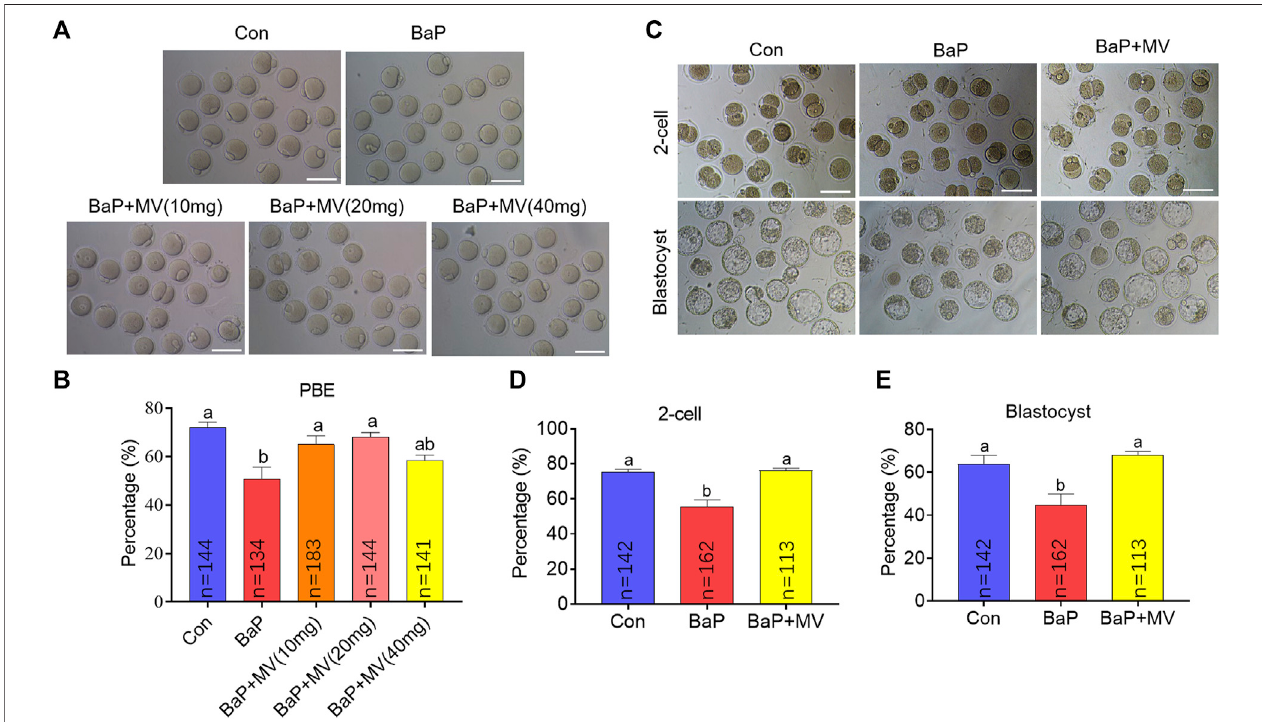
FIGURE 1 | Effects of MV on meiotic maturation and embryo development in BaP-exposed mice. Oocytes were matured in vitro to examine meiotic progression. (A) Representativeimagesofoocytesat13 hof invitro maturationindifferentgroups. (B) Theratesof fi rstpolarbodyextrusion(PBE)intheCon,BaP,BaP+MV(10 mg), BaP + MV (20 mg), and BaP + MV (40 mg) groups. BaP, Benzo(a)pyrene. MV, mogroside V. In vitro fertilization was performed to determine oocyte developmental competence. (C) Representative images of 2-cell embryos and blastocysts in the Con, BaP and BaP + MV groups. (D) Percentage of 2-cells in the Con, BaP and BaP+MVgroups. (E) Percentageofblastocysts intheCon,BaPandBaP+MVgroups. Scalebar (cid:2) 100 μ m.Thedataarepresented asthemean ± SEM. a-b Meansnot sharing a common superscript are signi fi cantly different ( p <